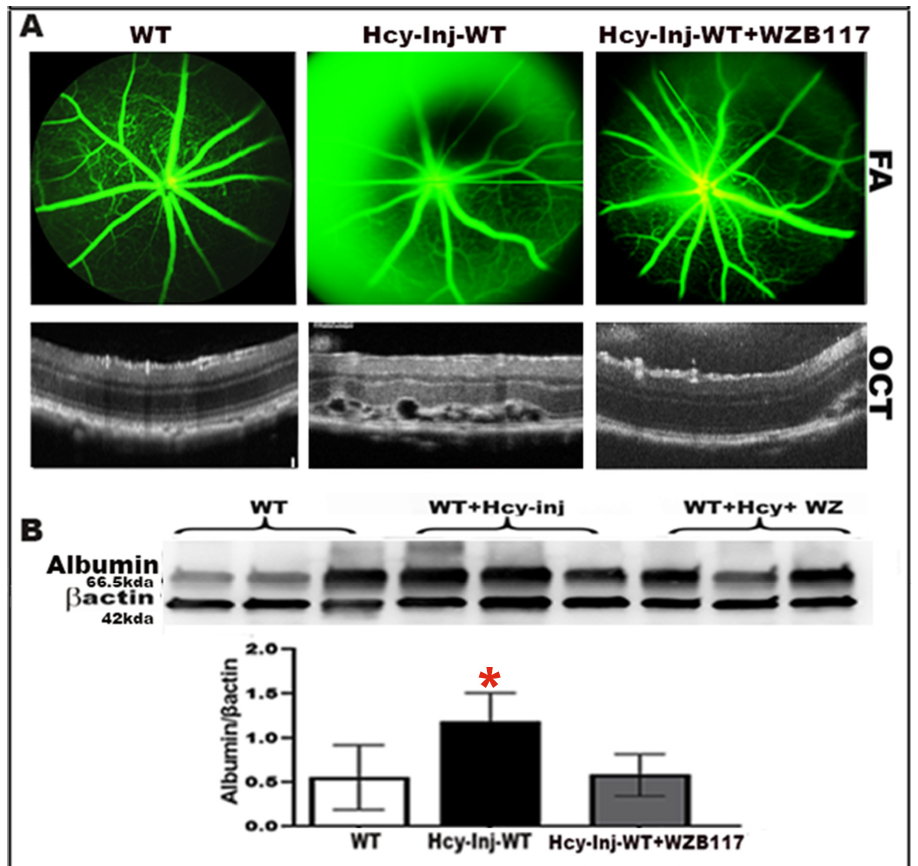
Figure 4. Inhibition of glycolysis protects the retina from Homocysteine induced blood–retinal barrier (BRB) dysfunction and choroidal neovascularization (CNV). C57BL6 mice with/without Hcy-thiolactone intravitreal injection in the presence or absence of intraperitoneal (IP) injection of GLUT1 pharmacological inhibitor WZB117 were evaluated 72 h after Hcy injection by ( A ) FA evaluation (upper panel), showing normal well-formed vessels in WT mouse; however, Hcy-injected mouse retinas show obvious vascular leakage manifesting as diffused hyperfluorescence, which was markedly reduced after blocking GLUT1 with WZB117. The OCT examination (lower panel) shows a normal appearance in WT mouse retinas, as well as obvious interruption of retinal morphology with notable hyporeflective subretinal lucency, focal hyperreflective spots, and choroidal neovascu- larization in Hcy-injected mice retinas. Blocking GLUT1 1 was able to reduce the retinal disruption, and it improved retinal structure and CNV induction after Hcy injection in WT-type mice (n = 6 mice/group. ( B ) Western blot evaluation of albumin leakage in mouse retinas after perfusion of mice with PBS solution. Blocking of GLUT1 was able to decrease the albumin leakage in the retinas, which was significantly increased in the Hcy-injected mice eyes. * p < 0.05 as compared to WT and WZB117 injected